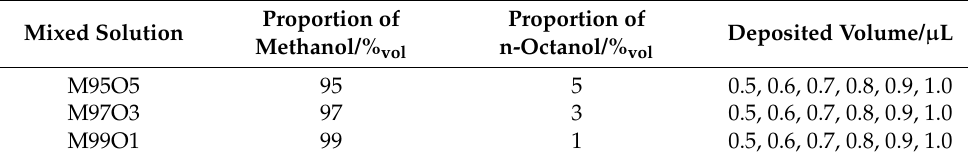
Table 3. The volume and mixing ratio of mixed solution.